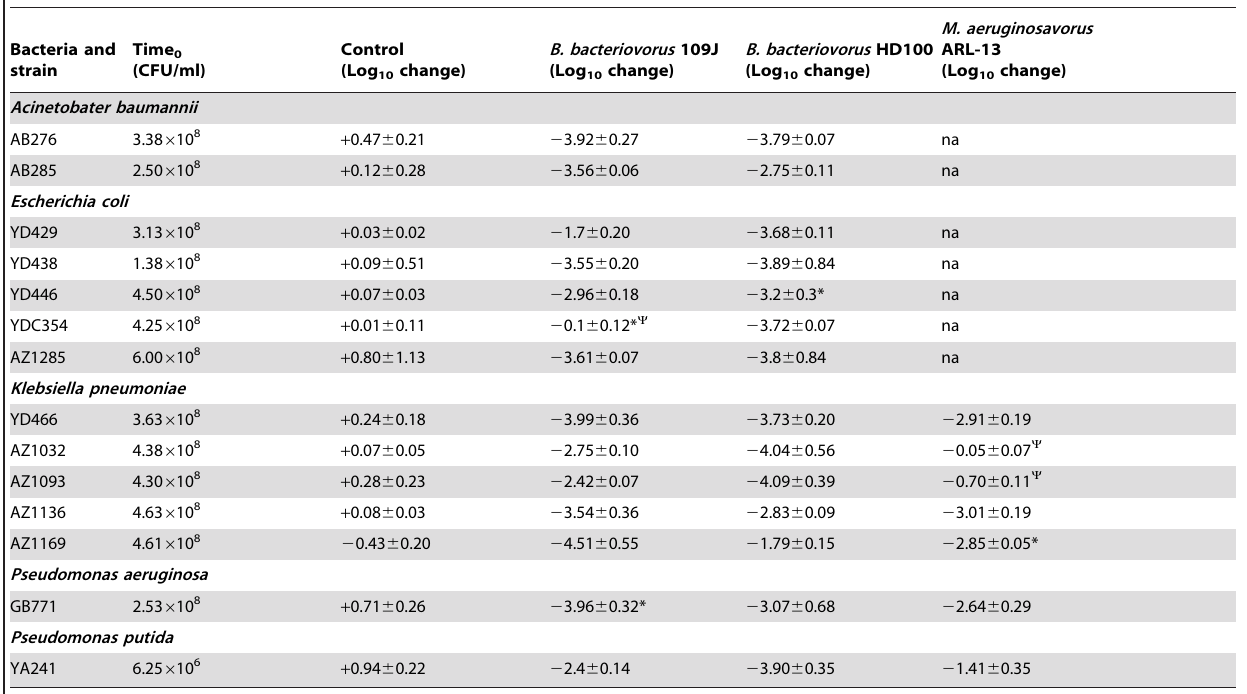
Table 2. Change in host viability following predation.